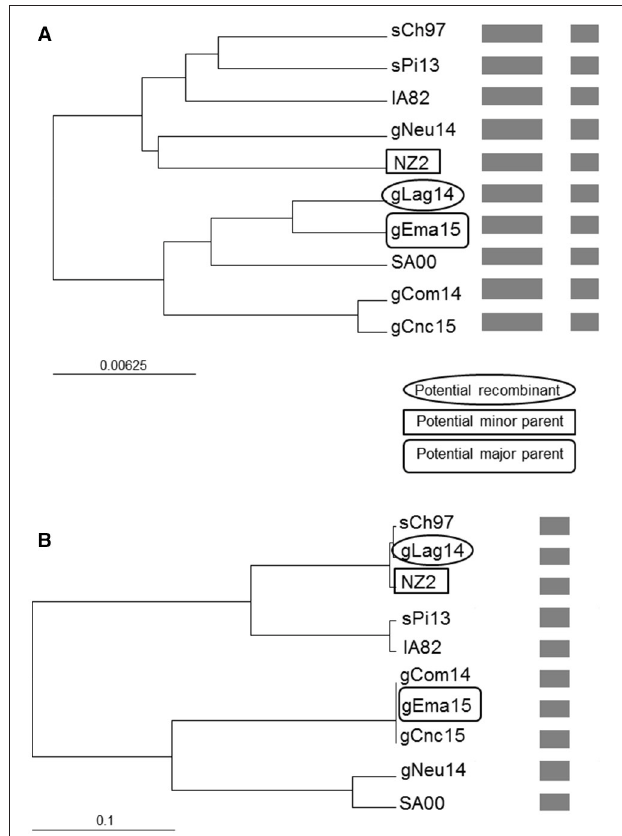
FIGURE 7 | Phylogenetic recombination evidence. UPGMA trees regions derived from (A) major parent (1–1,079 and 1,590–2,085) and (B) minor parent (1,080–1,589). A schematic representation of the alignment is presented after the names of the isolates. The scale bars are expressed in relative nucleotide sequence